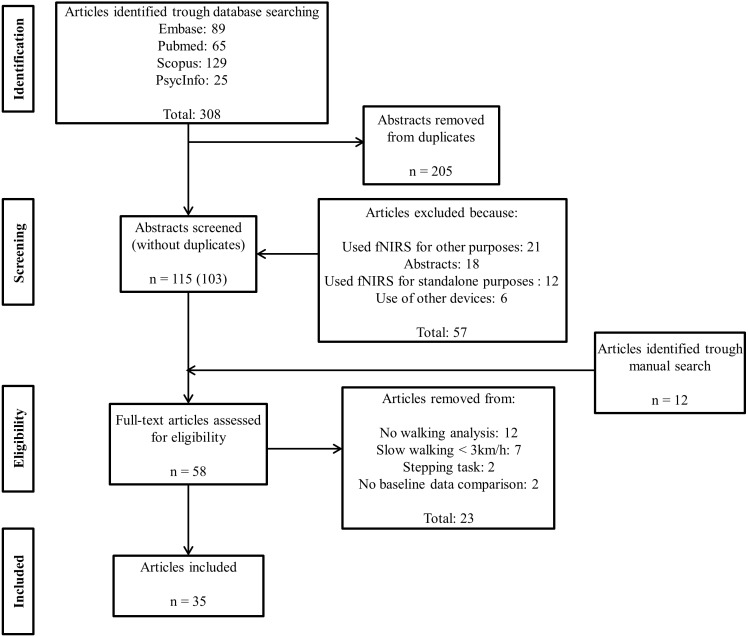
Flowchart of the article selection process.